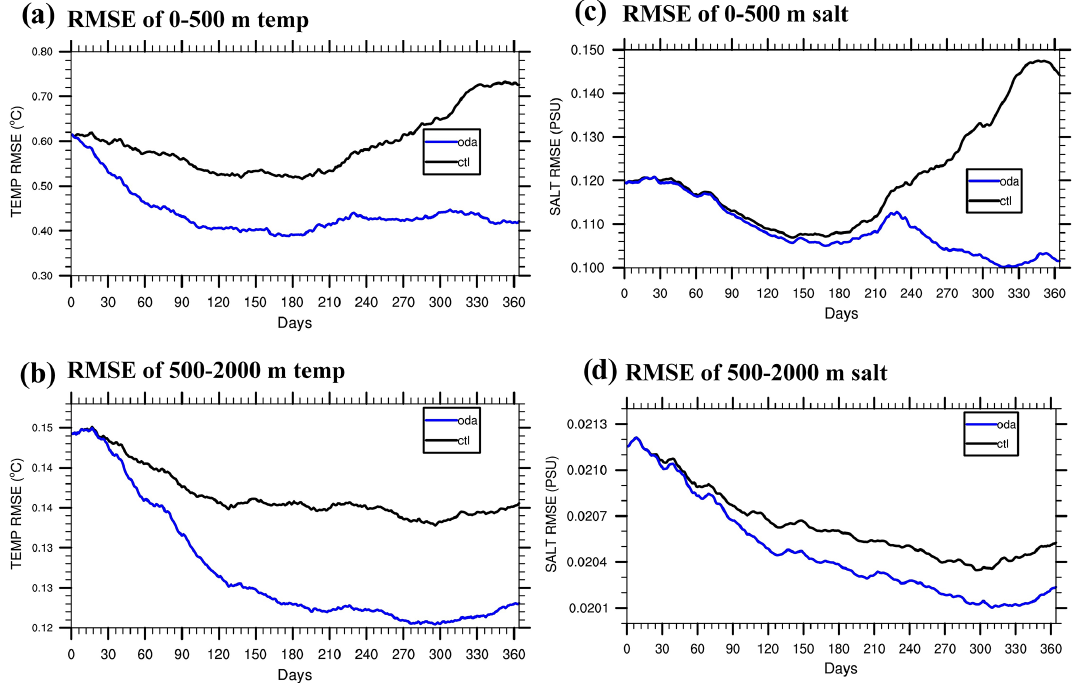
Figure 12. Time series of RMSEs of (a) 0–500m and (b) 500–2000m ocean temperature and (c) 0–500m and (d) 500–2000m ocean salinity from ctl (black line) and oda (blue